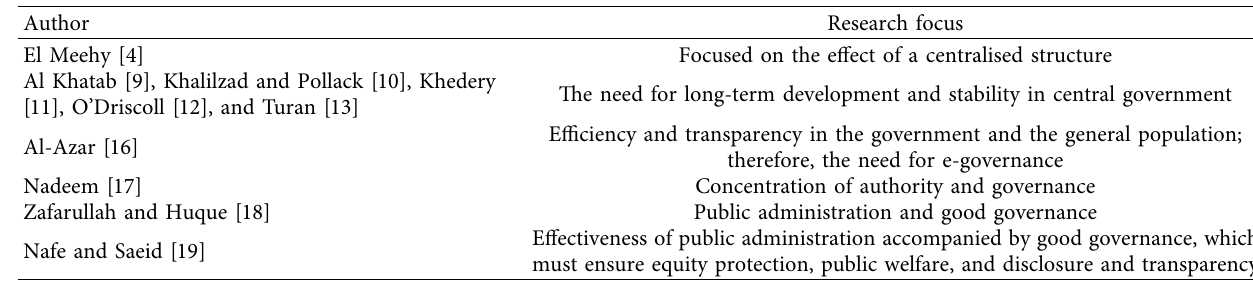
Table 1: Literature sources for the identification of research